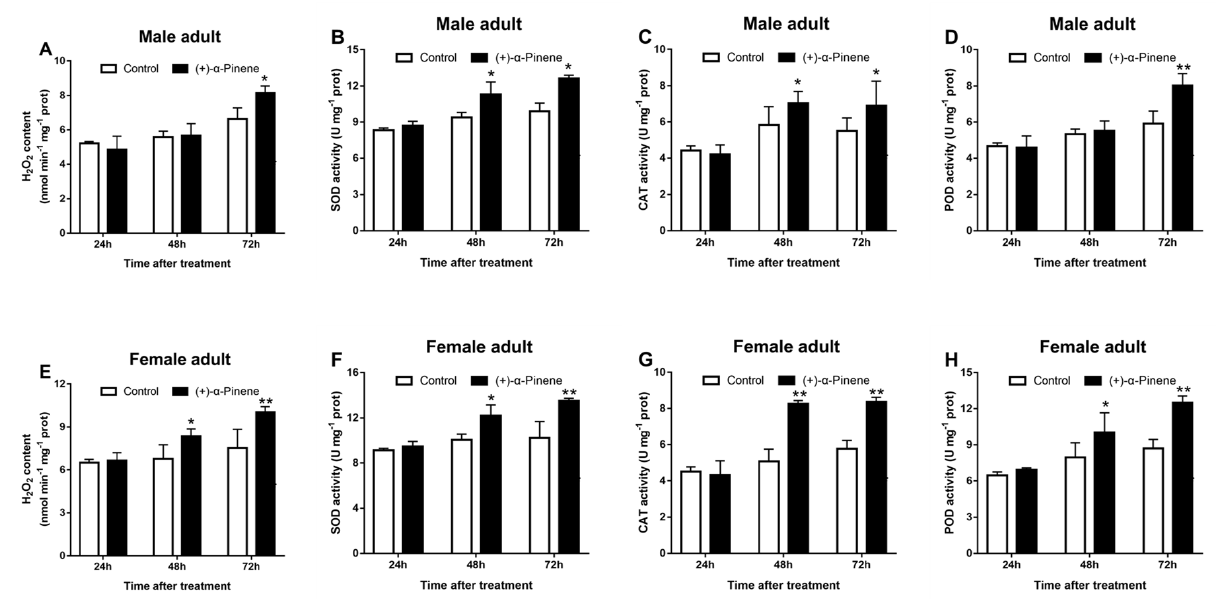
Figure 5. Effects of (+)- α -pinene exposure on H 2 O 2 generation and the activities of antioxidant enzyme in D. armandi. The surviving adults were collected at 24, 48, and 72 h post exposure to LC 50 (+)- α -pinene. The H 2 O 2 content ( A , E ) and the activities of SOD ( B , F ), CAT ( C , G ), and POD ( D , H ) in the midgut of adults were determined spectrophotometrically. The asterisk indicates a significant difference between different treatment groups (* p < 0.05, ** p < 0.01, independent Student’s t -test). All values are the mean ± SE, n =